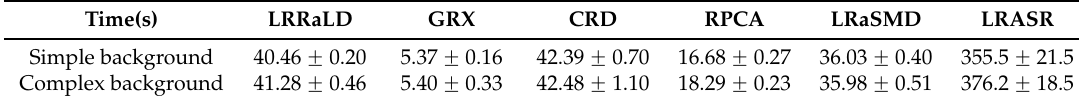
Table 3. Execution time of different methods on synthetic data sets (20 repetitions).